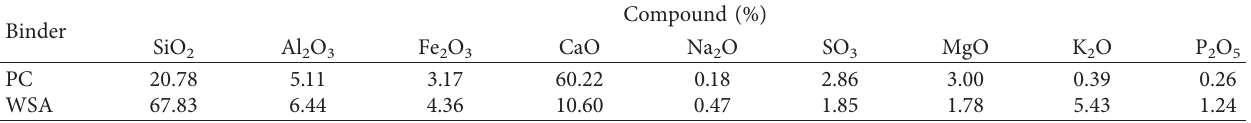
Table 1: Chemical composition of PC and